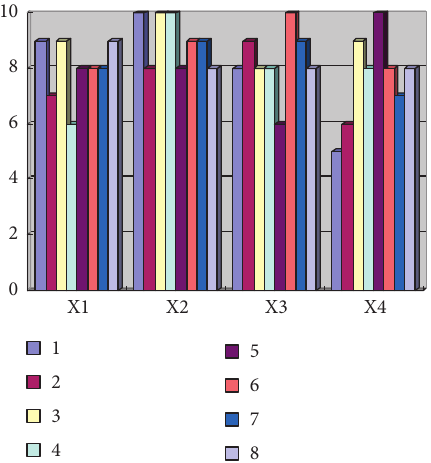
Figure 3: Experimental data.